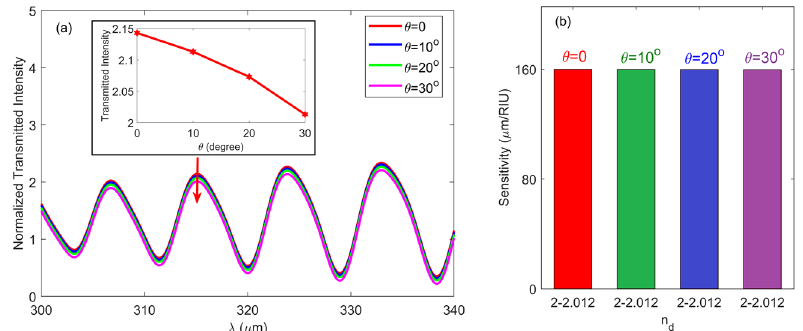
Figure 8. ( a ) Normalized transmission spectra for interferometers with different incident angle θ operating at room temperature. Inset: normalized transmitted intensity versus incident angle θ at constructive wavelength of 315.1 μm. ( b ) Calculated sensitivities for structures with a different incident angle θ .